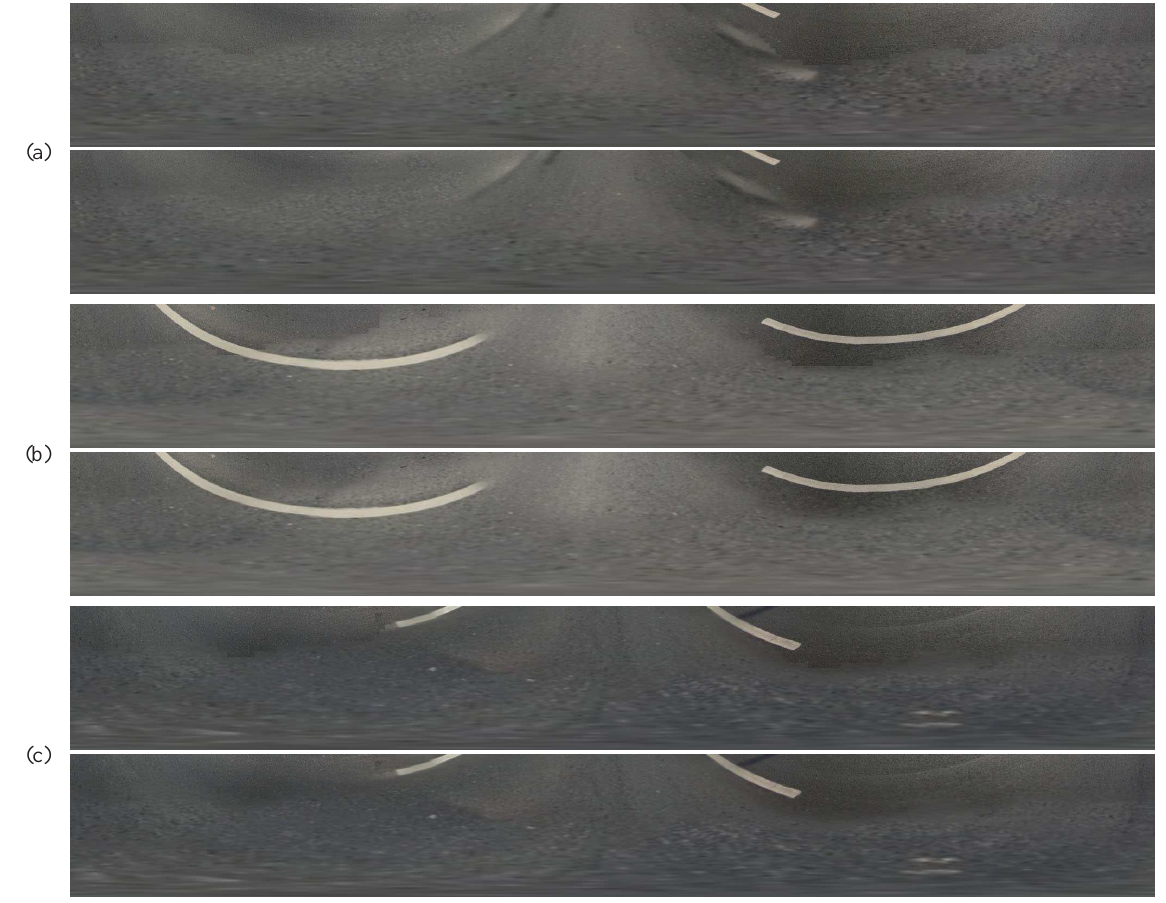
Figure 13. Comparisons of three completed streetview panoramas before feathering (top images) and after feathering (bottom images).